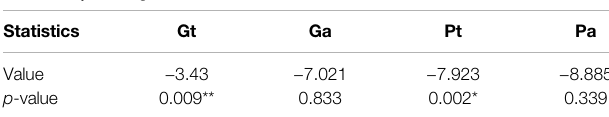
TABLE 6 | Cointegration